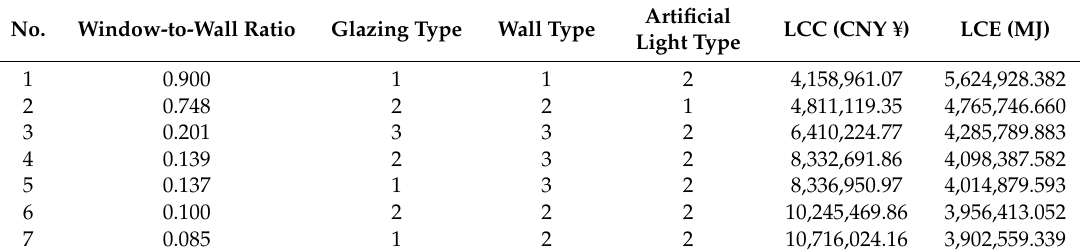
Table 4. Information about the fifth design with three lighting control